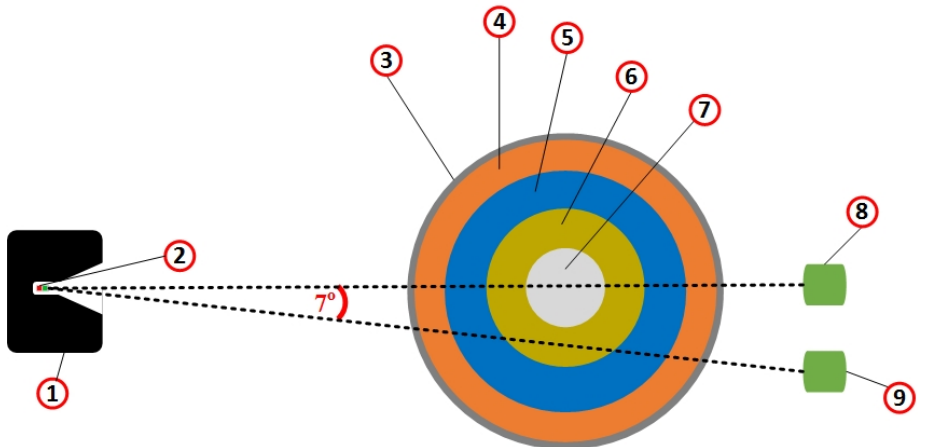
Figure 1. Simulated geometry: (1) Radiation shield, (2) Radioactive sources, (3) Steel pipe, (4) Scale layer, (5) Water phase, (6) Oil phase, (7) Gas phase, (8) First transmission detector, (9) Second transmission detector.